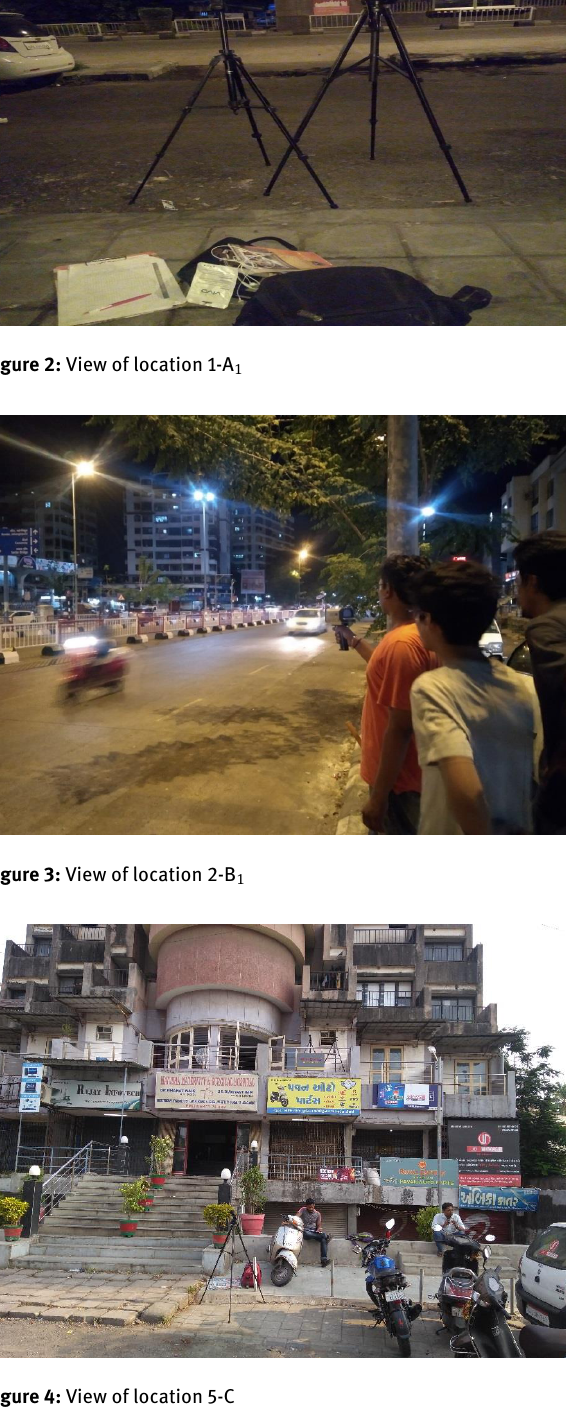
Figure 4: View of location